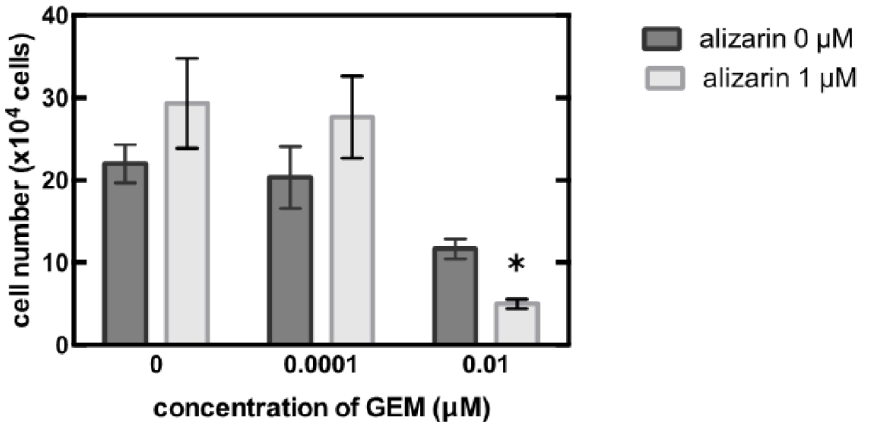
Figure 4. MiaPaCa-2 cells were treated with 0–0.01 µM gemcitabine (GEM) and 0 or 1 µM alizarin for 48 h, and the cell number was counted. Data represent mean ± SEM. n = 3. * p < 0.05.